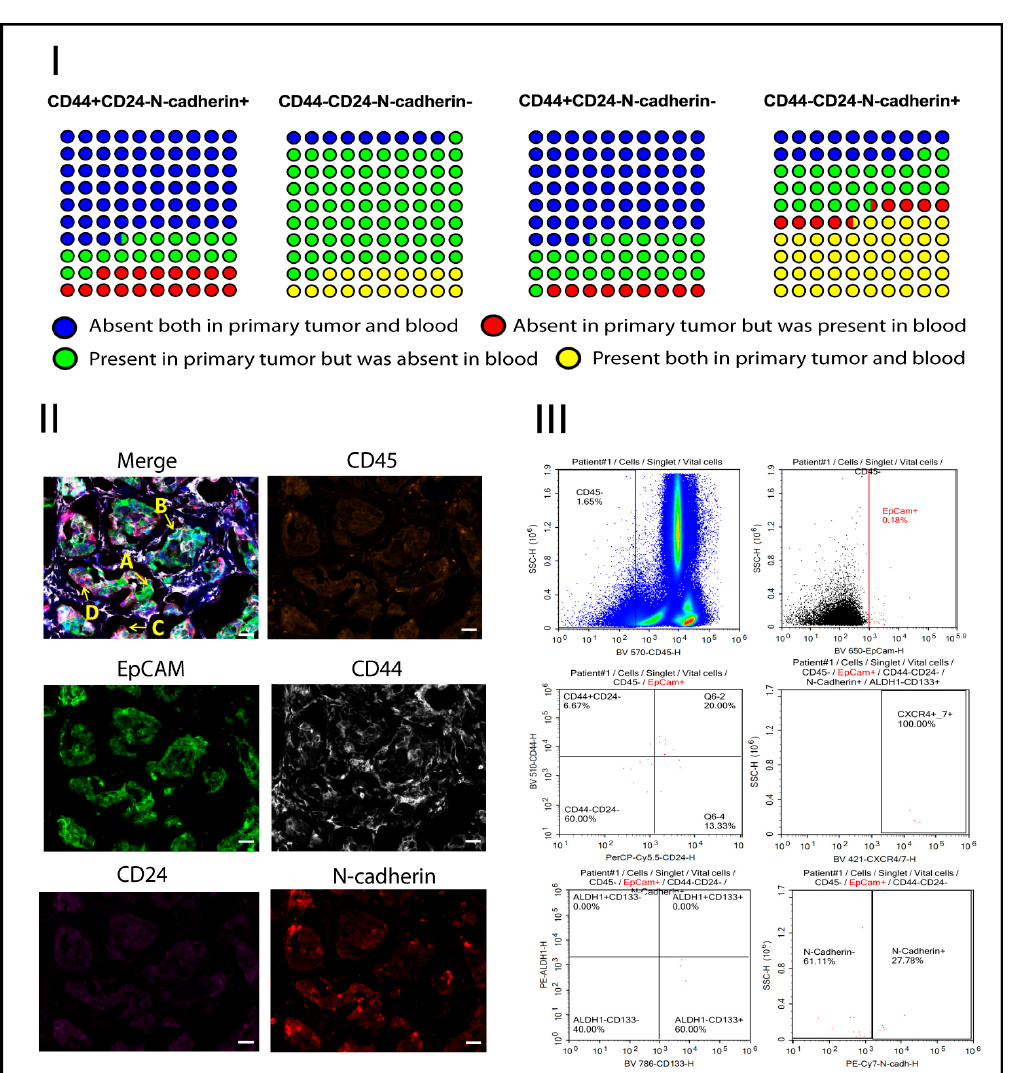
Figure 4. Matching tumor-cell phenotypes of primary tumor and peripheral blood: (I) variants of tumor-cell presence in primary tumor and peripheral blood; (II) subsets of tumor cells with and without EMT and / or stem features in primary breast cancer: A—CD45-EpCAM + CD44-CD24 -N-cadherin-, B—CD45-EpCAM + CD44 + CD24-N-cadherin-, C—CD45-EpCAM + CD44 + CD24-N- cadherin + , D—CD45-EpCAM + CD44-CD24-N-cadherin + (scale bar, 40 um); (III) subsets of CTCs with and without EMT and / or stem features in peripheral